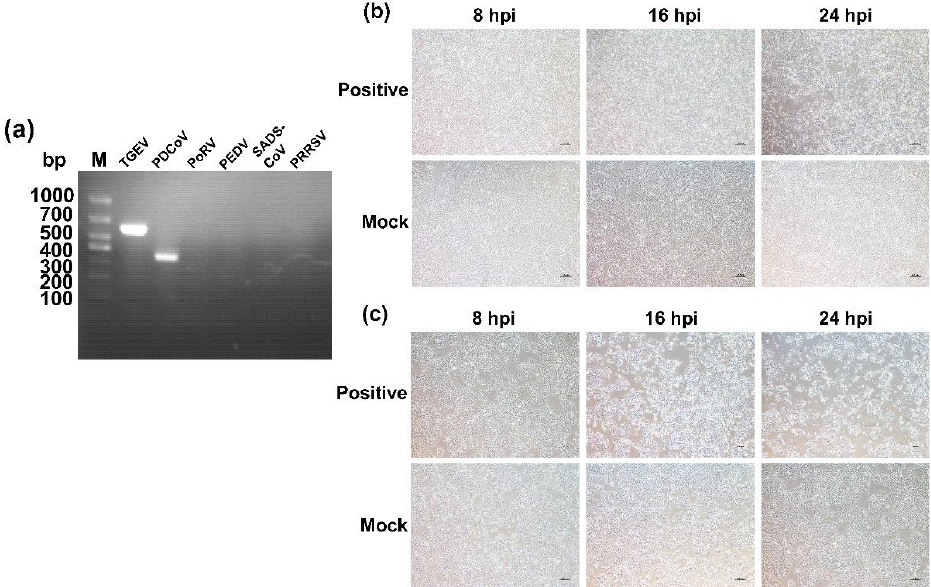
Figure 1. Isolation and identification of TGEV and PDCoV. ( a ). RT-PCR was performed on the samples to ensure no other common viral contamination. ( b ). Isolation and passage of TGEV in ST cells (40×). ( c ). Isolation and passage of PDCoV in LLC-PK cells (40×).